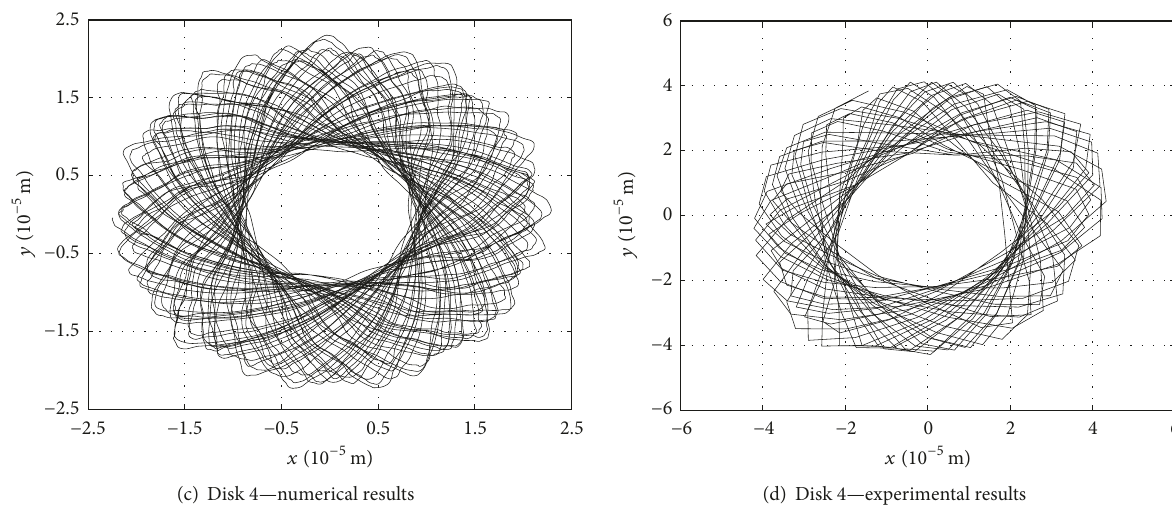
Figure 20: Orbit of disk 2 and disk 4 with 𝜔 1 = 210 rad / s and 𝜆 = −1.65